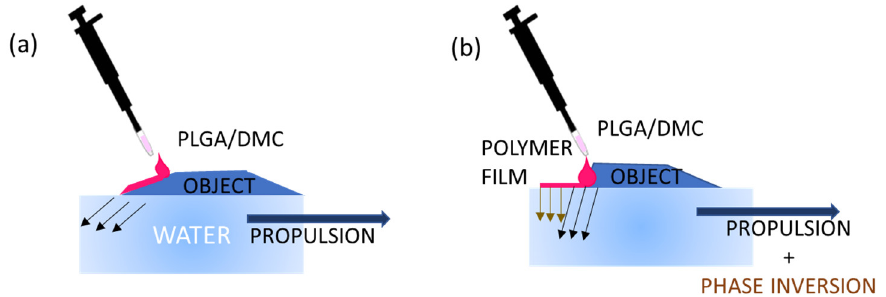
Figure 2. Scheme illustrating the mechanism of release of polymeric solution drops on two different side geometries. ( a ) Sloped side for slow release: the droplet is released along the oblique side wall so that only a small volume will be in contact with water, missing the free air–water surface needed for spreading, and as a consequence, only the propulsion mechanism is activated. ( b ) Almost perpendicular wall for fast release: the droplet is released just on top of the side and, once dispensed, will immediately and entirely face the water surface, activating film formation and Marangoni propulsion at the same time.